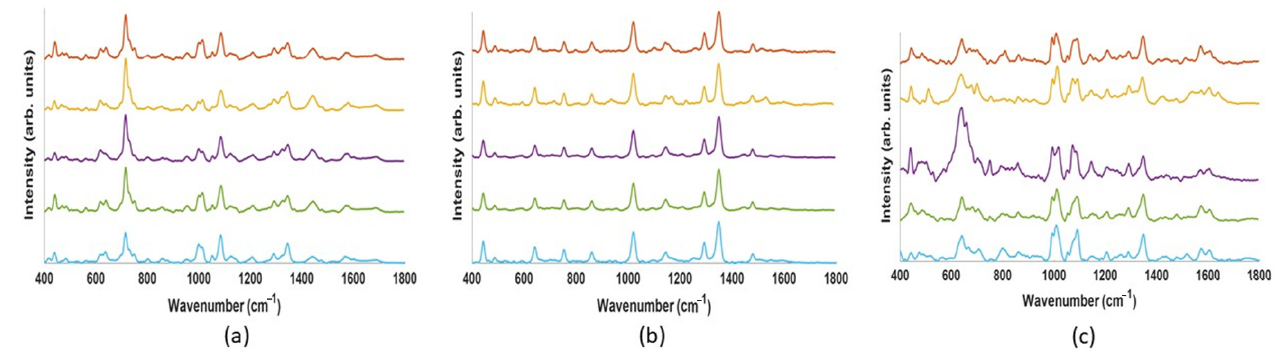
Figure 7. Repeatability of SERS spectra of 3 kDa filtrates of human serum, saliva and urine samples with added nanostars (nanostar: sample = 1:19 in volume ratio). ( a ) From five independent experi- ments of serum. ( b ) Spectra from five different saliva samples, that from each donor depicted in a different colour. ( c ) Spectra from five different urine samples, that from each donor depicted in a different colour. For all spectra, source wavelength was 785 nm, laser power 125 mW, and acquisition time was 10 s per spectrum.